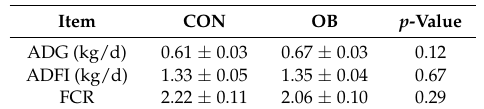
Table 1. The growth performance of pigs fed either control or oat bran diet during the 28 day experimental period 1 .